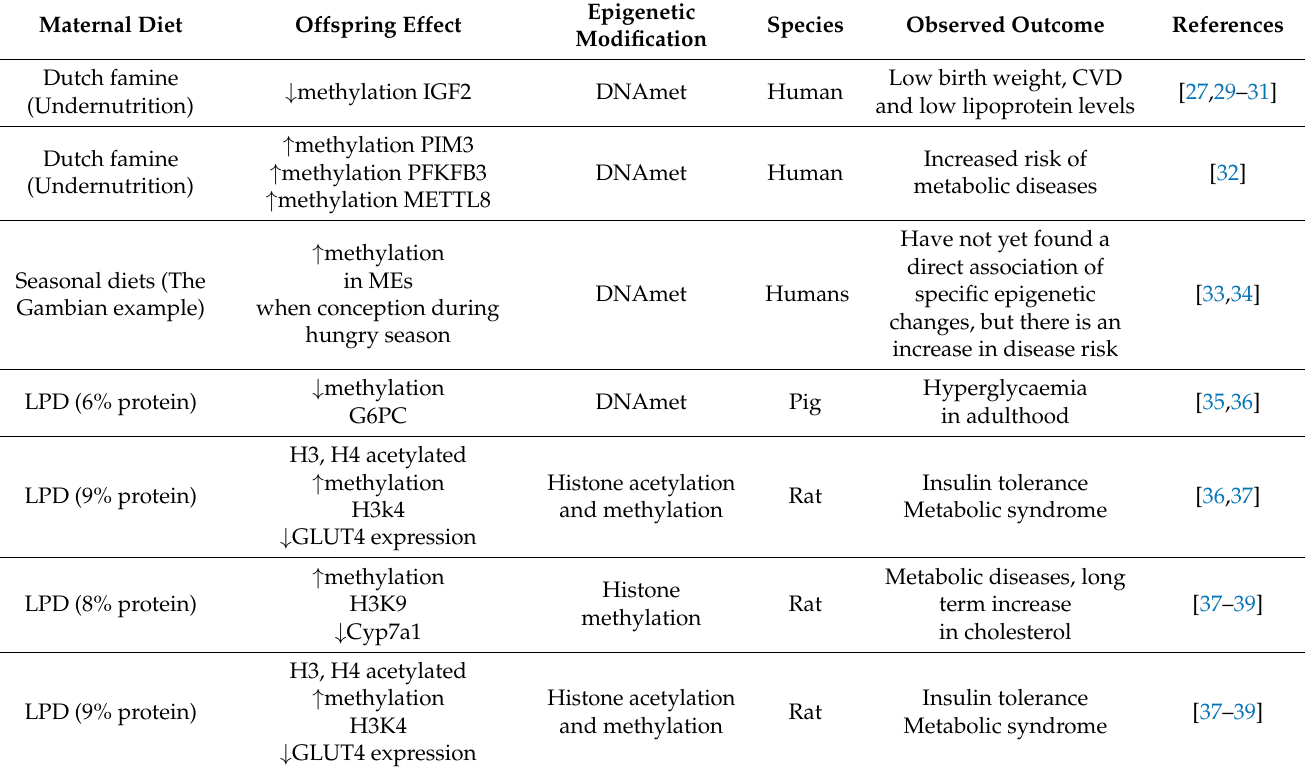
Table 1. Maternal diets models and epigenetic modifications in